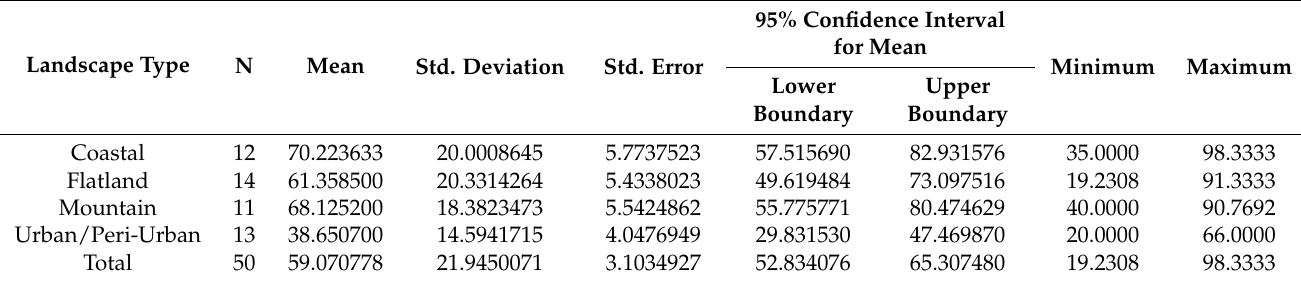
Table 1. Descriptive statistics for the raw LAP scores per type.